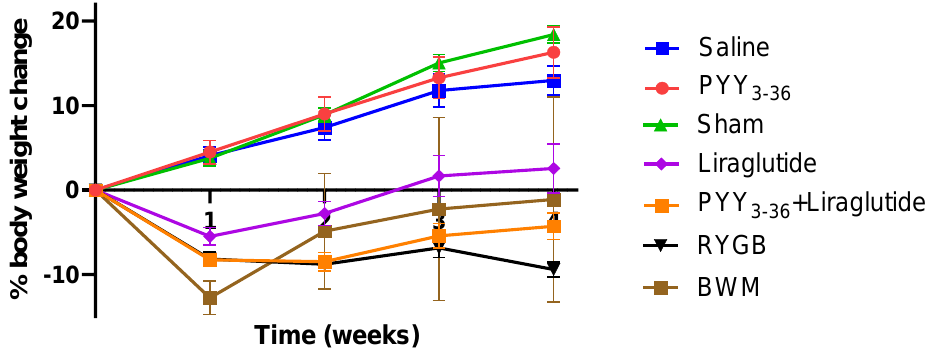
Figure 1. RYGB and PYY3-36 + liraglutide induce body weight loss in diet-induced obese Wistar rats. Body weight in percent (%) weight change from baseline (intervention) of RYGB ( n = 14), sham ( n = 11), PYY3-36 + liraglutide ( n = 10), liraglutide ( n = 5), PYY3-36 ( n = 5), BWM ( n = 7), and saline ( n = 8) groups. Significant differences between RYGB and sham as well as between PYY3-36 + liraglutide and saline from week one on ( p ≤ 0.0001). Data are presented as mean ± standard error of the mean.